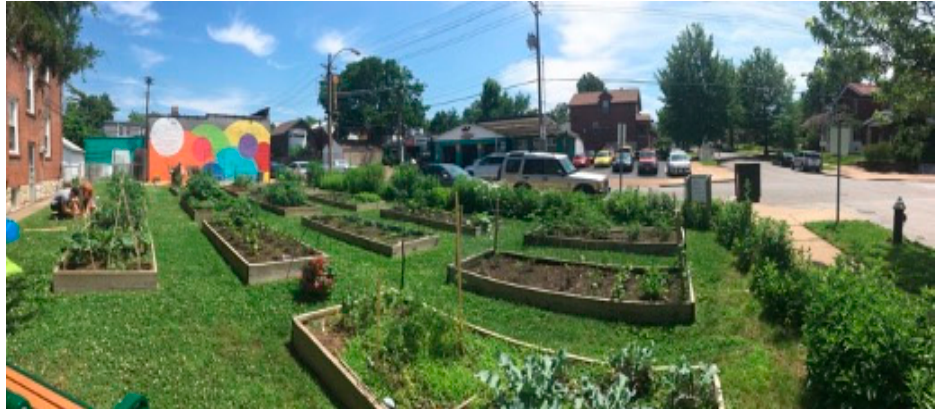
Figure 1. Example of one of the included community garden sites in Saint Louis. All of the survey sites were urban community gardens which consist primarily of raised beds and rows of produce maintained by volunteers and community members.